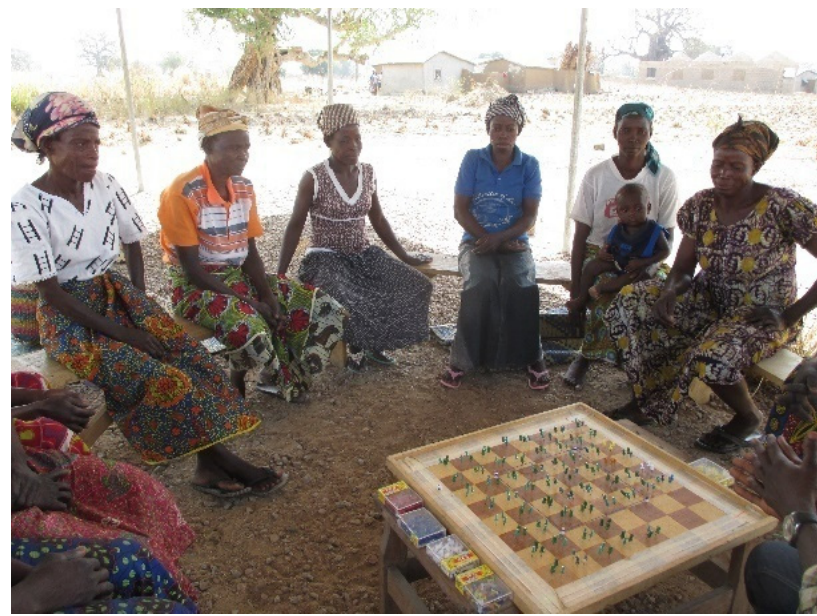
Figure 4. Some selected female players.